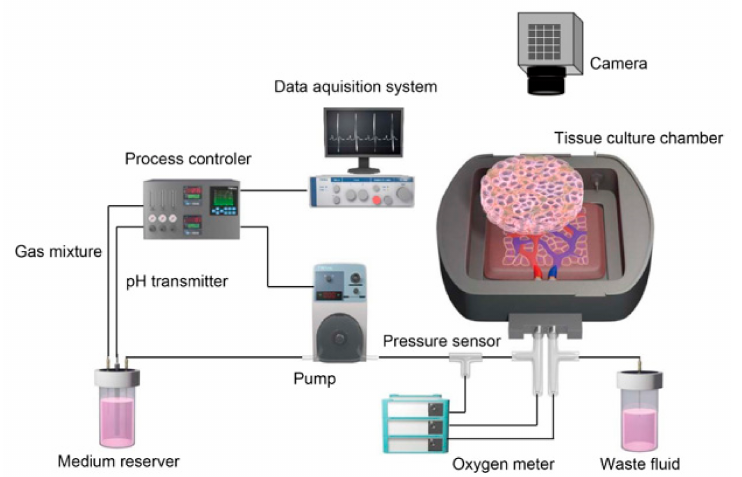
Figure 5. Tissue perfusion culture system and stacking of cell sheets on a vascular bed. The schematic diagram was drawn with the graphic design software, Adobe